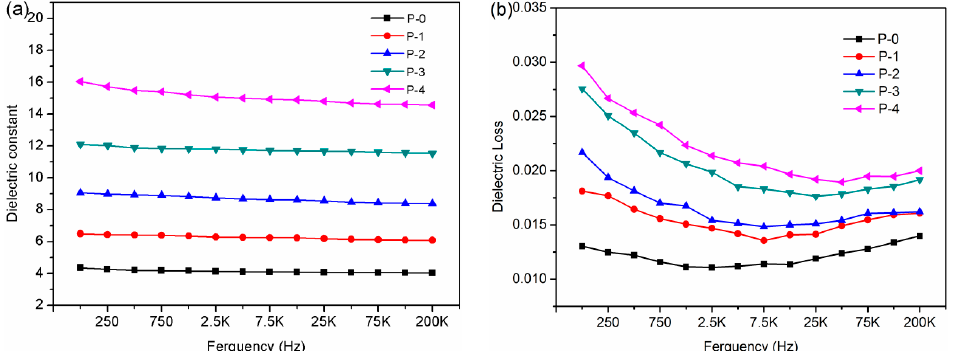
Figure 9. ( a ) Dielectric constant; and ( b ) loss tangent of CPEN/F-BaTiO 3 composite films as a function of